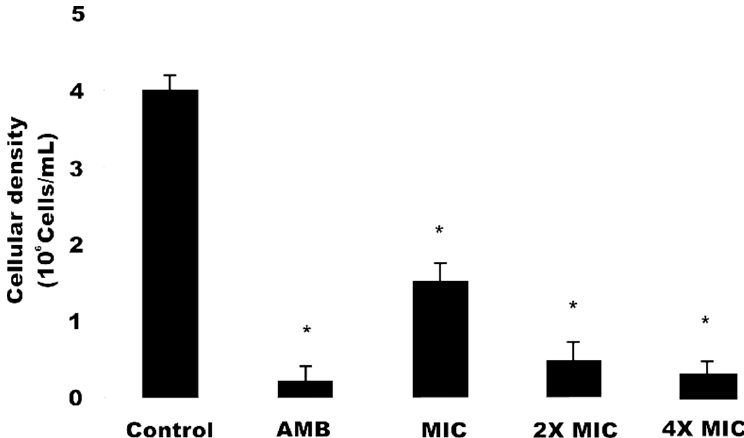
Figure 1. Effect of O. glomerata methanol extract on C. krusei cell viability using Propidium Iodide (PI). Data represent the mean and standard deviation (SD) of fluorescence during PI staining in two independent experiments with at least three replications. Analysis of variance (ANOVA) was performed followed by the Student-Newman-Keuls test ( p < 0.05). * indicates significant differences between the fluorescence intensity percentage of the staining with PI ( p ≤ 0.05). AMB, Amphotericin B; MIC, Minimum Inhibitory Concentration; 2MIC, Double the MIC value; 4MIC, Four times the MIC value.